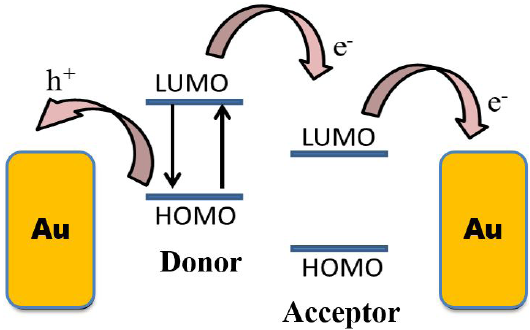
Figure 4. Energy diagram between electron donor and acceptor containing the processes of: generation, dissociation and transport. Table 2. Conductivity values for full and mixed pure and mixed fullerenes solubilized with chloroform. Conductivity (S m -1